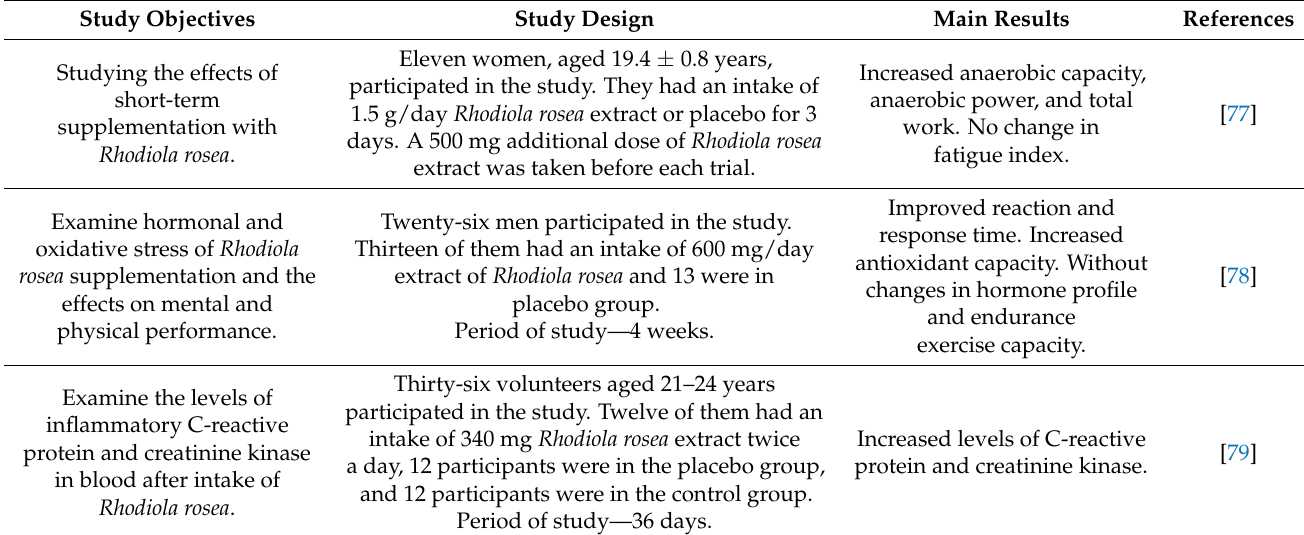
Table 5. Rhodiola rosea